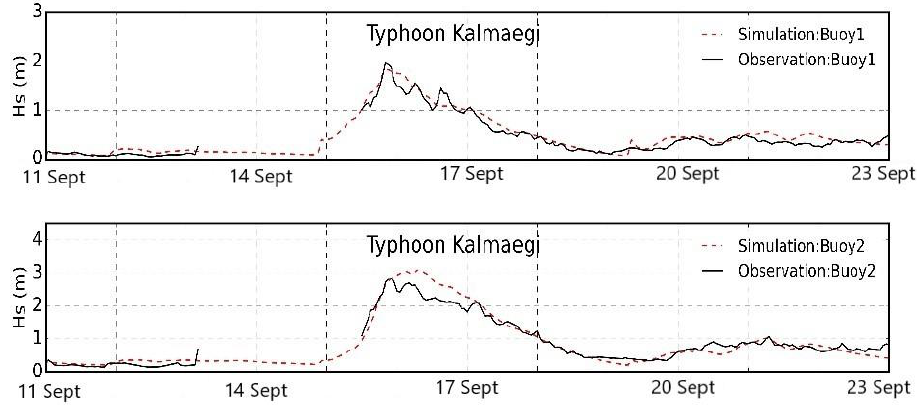
Figure 5. Time-series comparison of Hs during Typhoon Kalmaegi in 2014. Table 1. Statistical comparisons between wave WW3 hindcast data and buoy data.